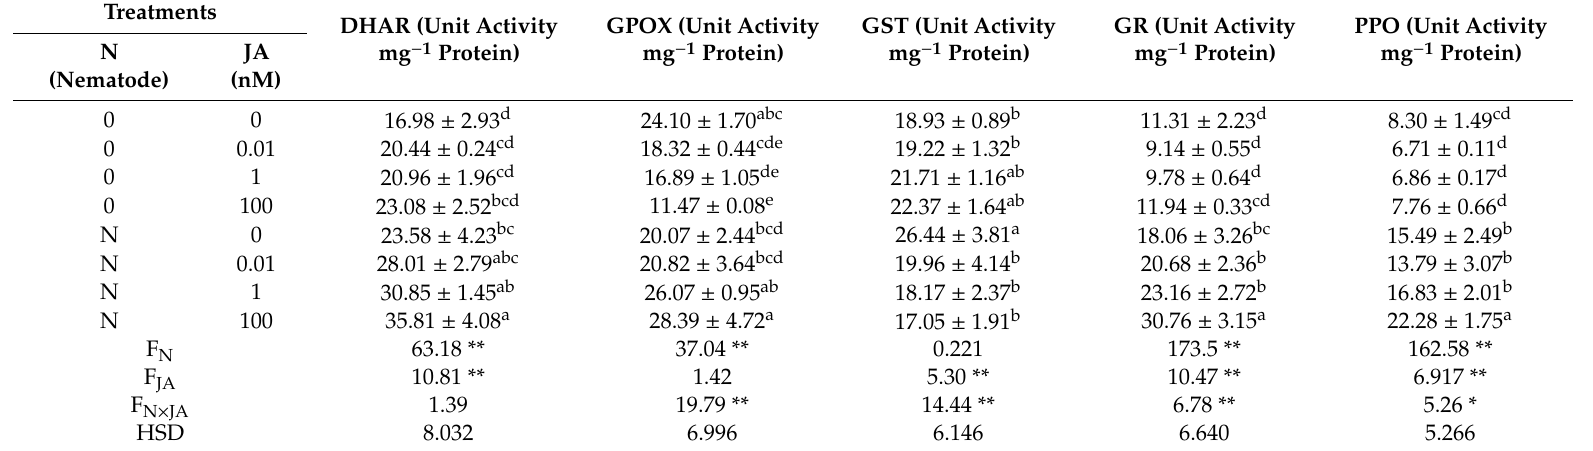
Table 3. E ff ect of seed soaking treatment of JA (0.01, 1 and 100 nM) on the activities of DHAR, GPOX, GST, GR, and PPO in tomato seedlings after seven days of nematode